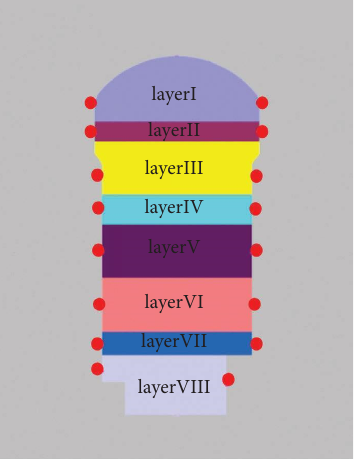
Figure 7: Location of measuring points in diferent excavation